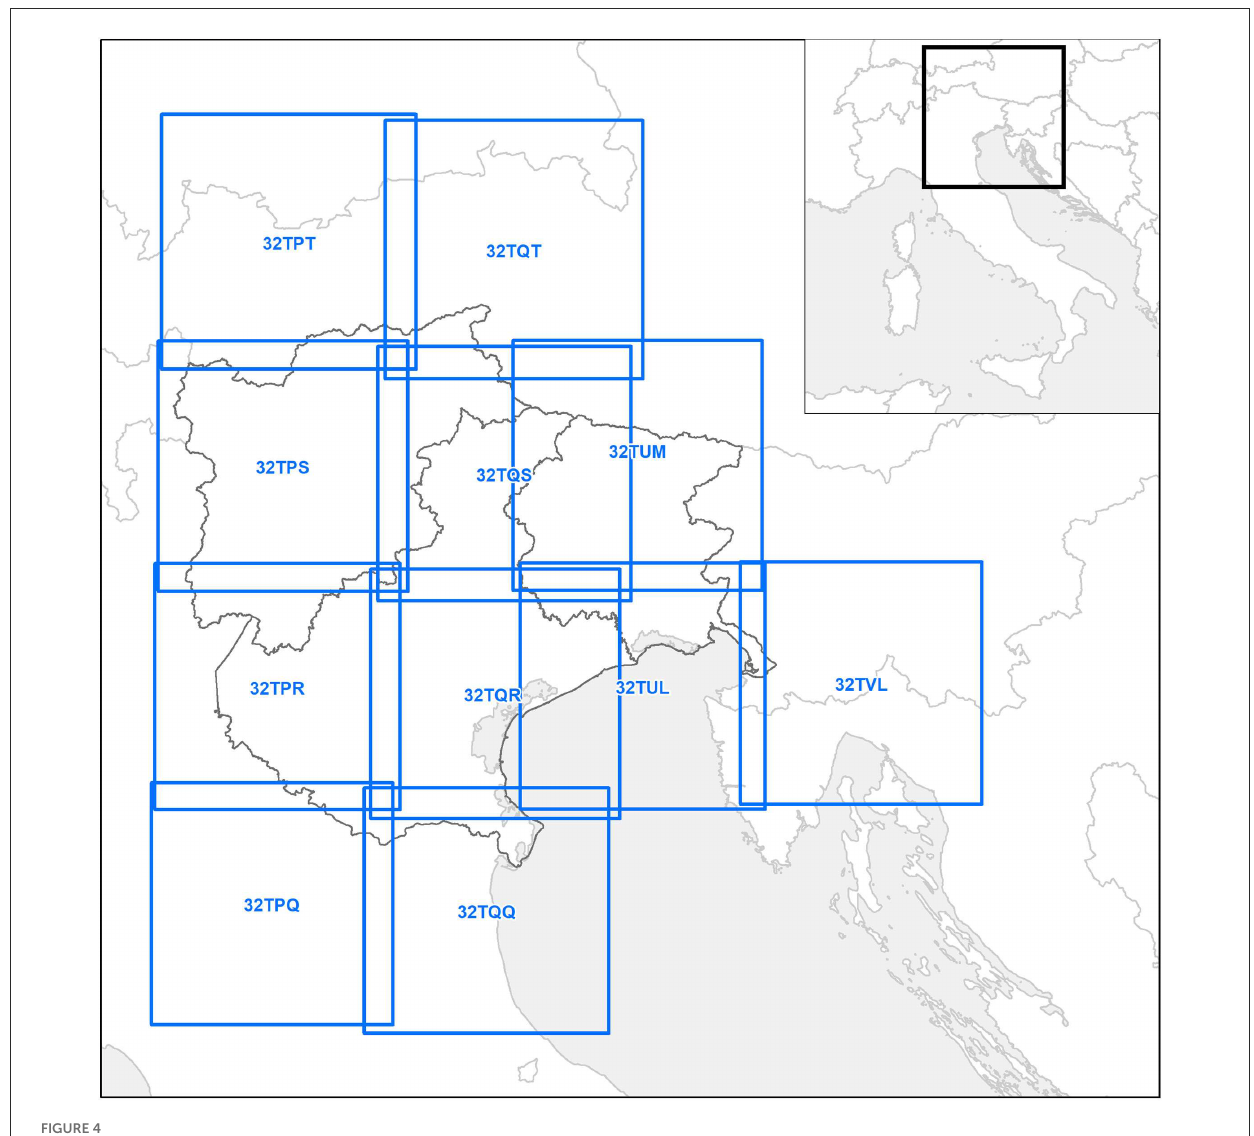
FIGURE4 The Sentinel-2 satellite footprints selected for the Local level (blue).